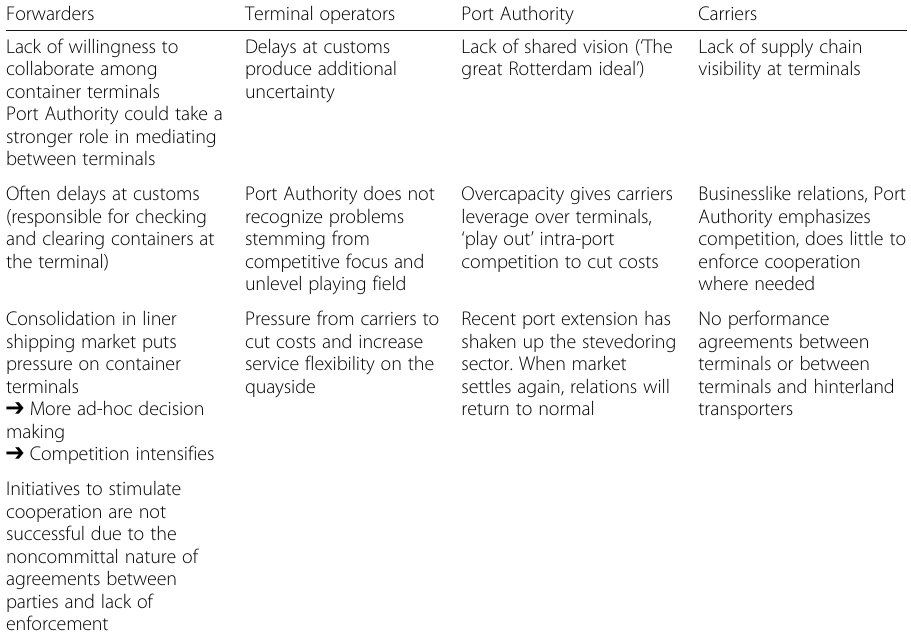
Table 2 Inventory of drivers of inter-terminal coordination problems, as identified by respondents Forwarders Terminal operators Port Authority